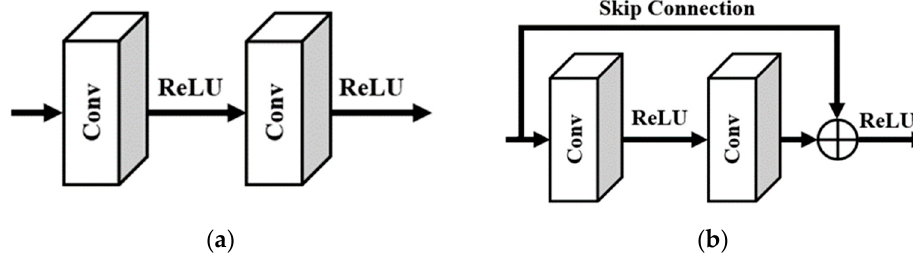
Figure 2. Network Model: ( a ) Existing Neural Networks; ( b ) ResNet’s Residual Block.